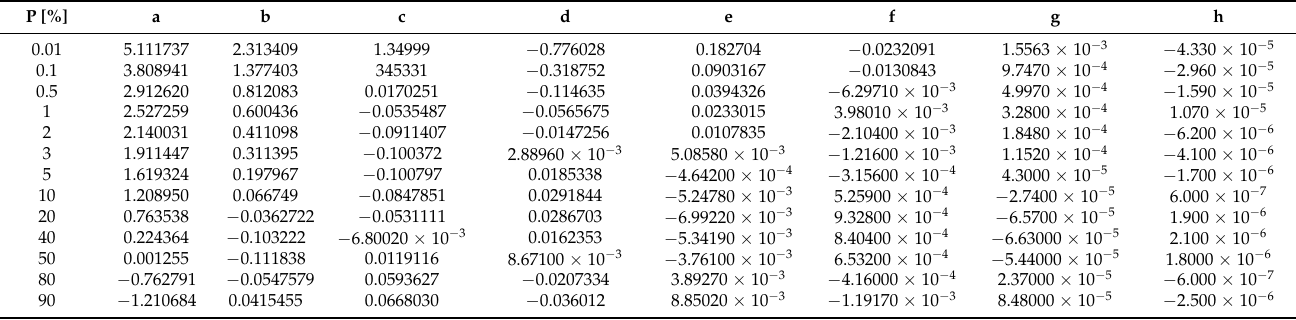
Table A2. The frequency factor for estimation with